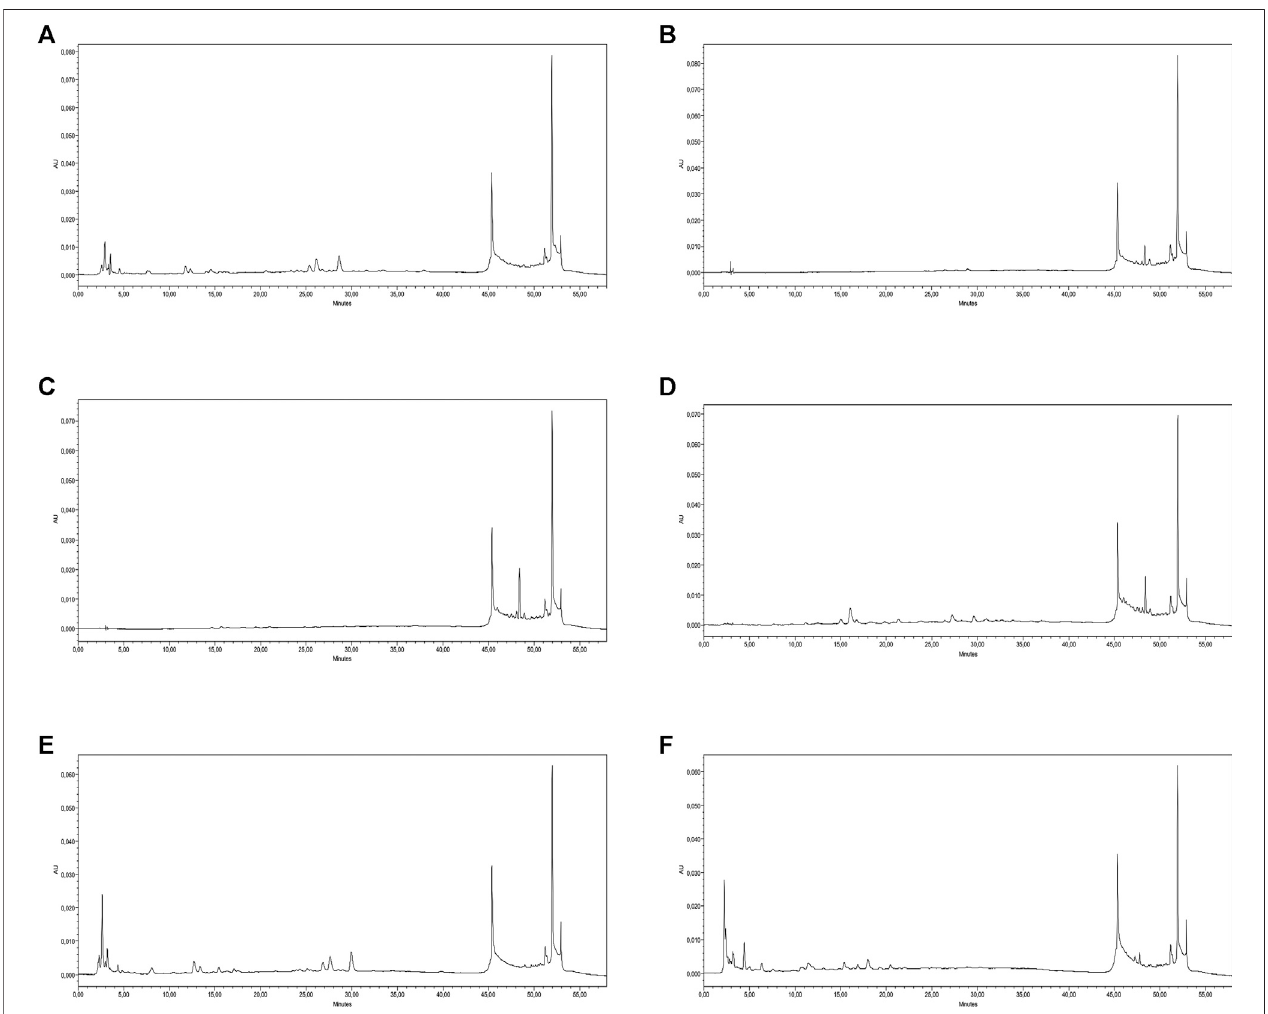
FIGURE1| HPLC-PDAchromatograms. (A) methanol, (B) n -hexane, (C) benzene, (D) chloroform, (E) ethylacetate,and (F) n -butanol)ofpolyphenolicsquanti fi ed in the tested extracts.